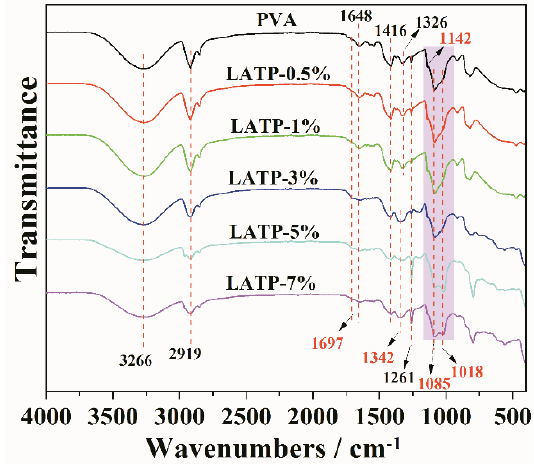
Figure 6. FT-IR spectra of LDHs@TA-Ti/PVA nanocomposites.